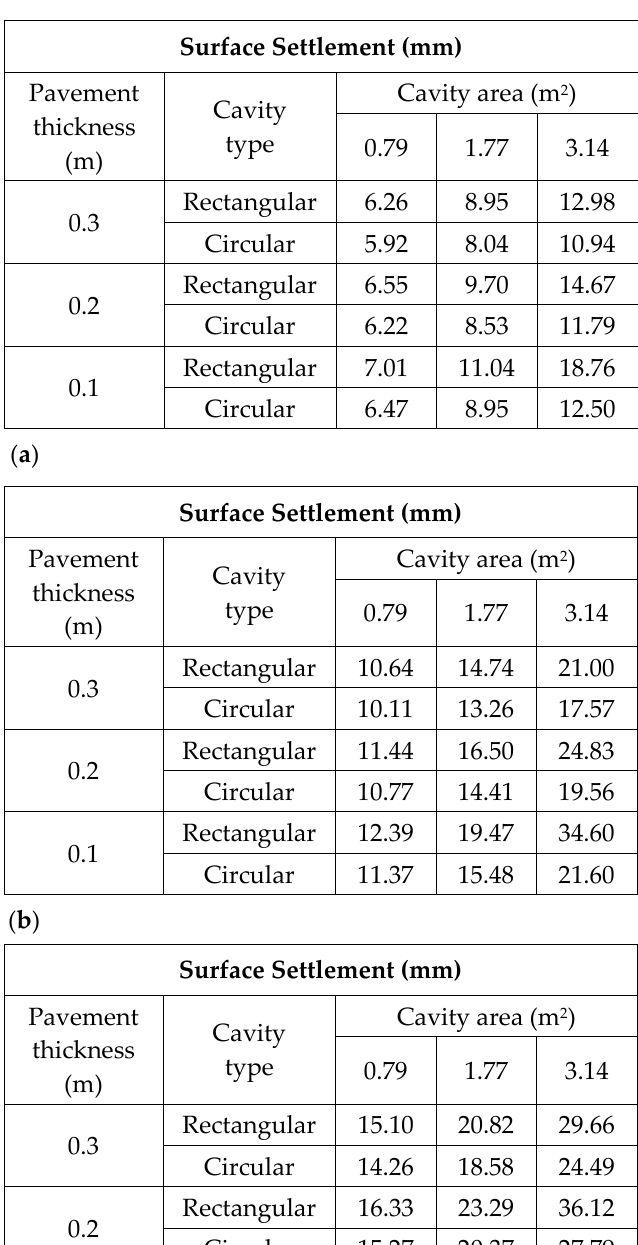
Figure 7. Surface settlement according to cavity area by pavement thickness (pavement elastic mod- ulus: 3000 MPa). Traffic load: ( a ) 12.7, ( b ) 25.4, and ( c ) 38.1 kN/m 2 .